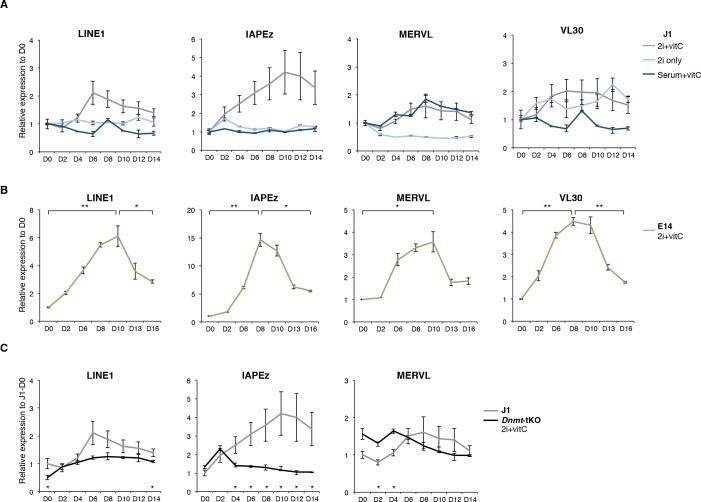
Two phases of transposon regulation correlate with rapid DNA methylation loss.(A) Expression of different transposons in J1 ES cells as measured by Nanostring during the conversion from serum to 2i+vitC (grey), 2i-only (light blue) and serum+vitC (dark blue). Data are expressed as fold change to D0 and represent mean ± SEM between eight (for 2i+vitC) or two (for 2i- and vitC-only) biological replicates. (B) Expression of transposons in E14 ES cells. Data are expressed as fold change to D0 and represent mean ± SEM between two biological replicates. p<0.05, **p<0.01 and ***p<0.001 (Student t-test). (C) Expression of transposons in Dnmt-tKO and J1 ES cells measured. Data are expressed as fold change to J1 D0 and represent mean ± SEM between three biological replicates (for Dnmt-tKO). *p<0.05, **p<0.01 and ***p<0.001 (unequal variances t-test between WT and Dnmt-tKO at a given day).